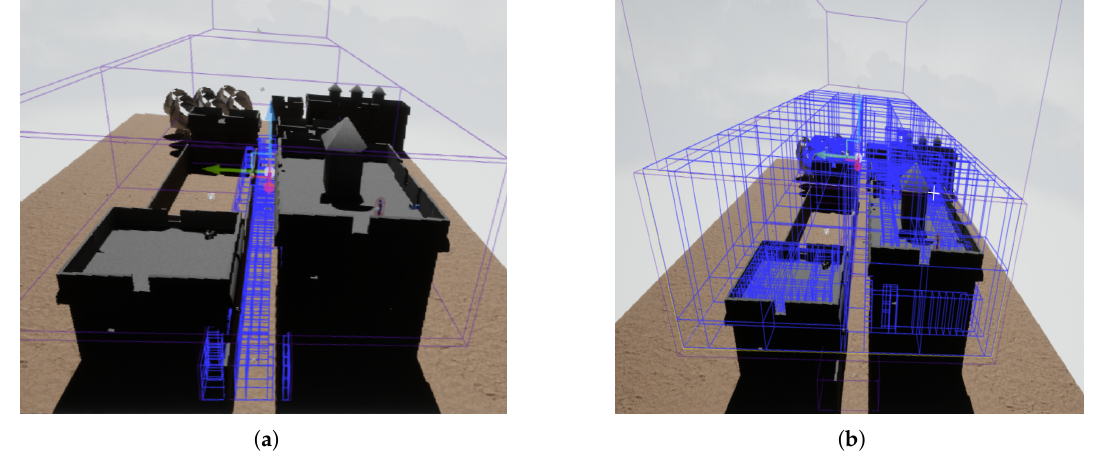
Figure 7. This figure provides a visualization of navigation cells that were generated to simulate the potential locations of a ground vehicle moving along a narrow corridor ( a ), and the potential flight path of a small UAS that hovers over above the roofs and corridor ( b ). These 4000 navigation cells were automatically generated in less than 1 min using a greedy